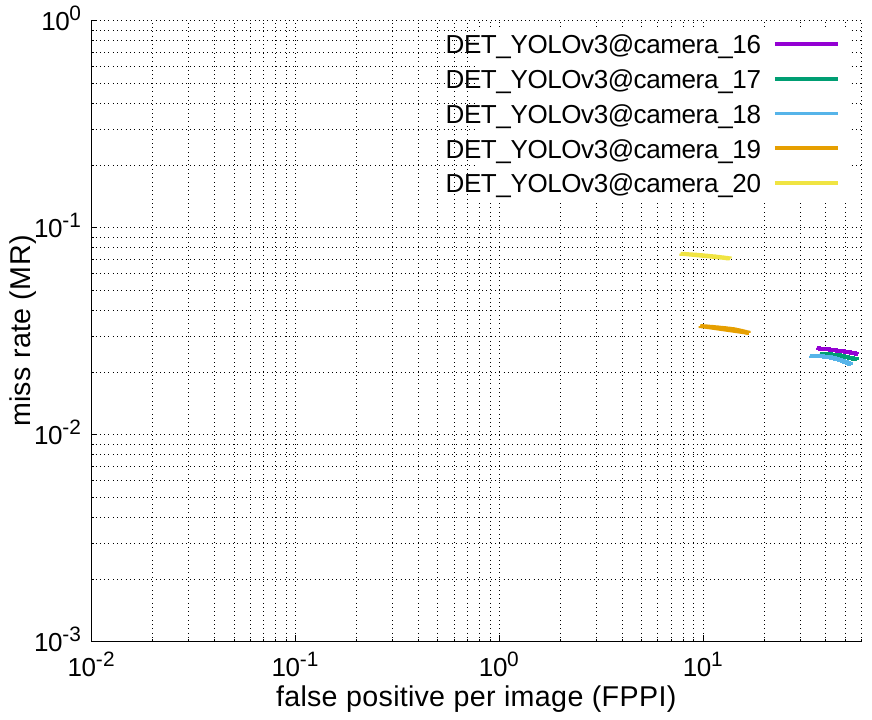
Figure 24. DET curves @ Cameras_16–20,